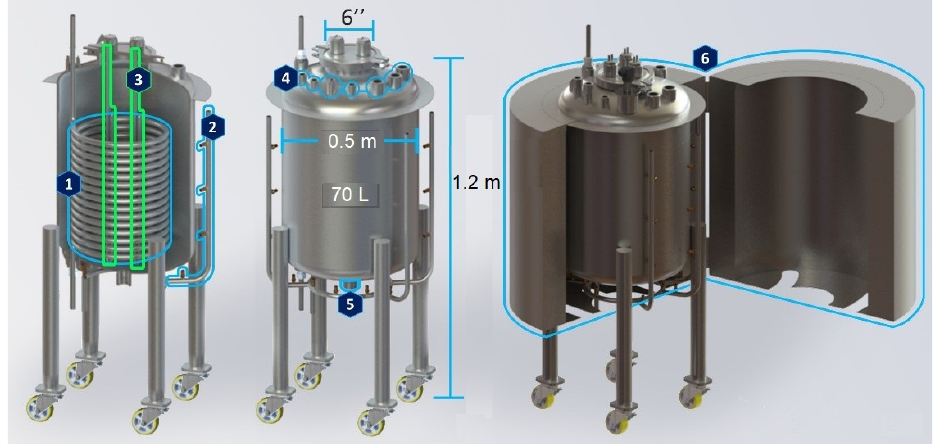
Figure 1. Experimental schematic of the hydrolyzer.